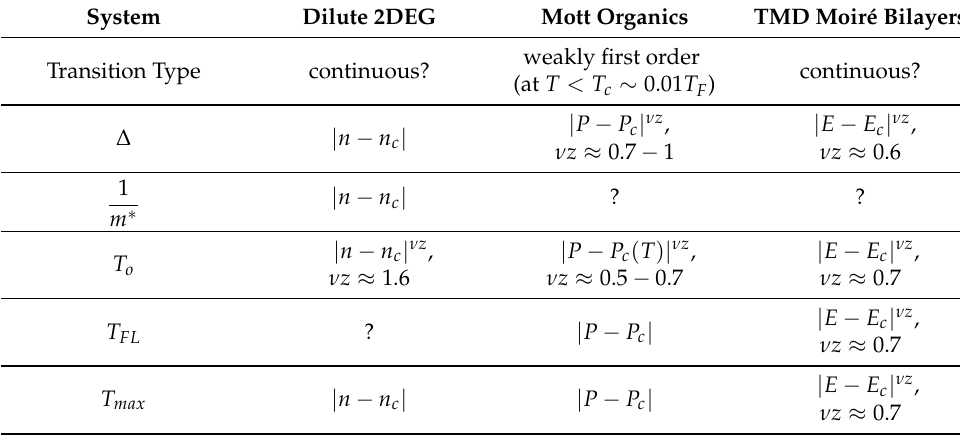
Table 1. A summary of available experimental results for the three classes of systems considered. The sources (references) are given in the text below. Question-marks indicate the lack of reliable data. Fermi liquid ( T 2 ) transport behavior has not been documented in 2DEG systems, in contrast to strong evidence for it in Mott organics and TMD moiré bilayers. Note that the characteristic energy scales ∆ , ( m ∗ ) − 1 , T FL , T max , as well as T o display similar continuous decrease towards the transition in all three systems, consistent with general expectations for quantum criticality. One should keep in mind that the error bars on the estimated exponent could be substantial, since the results typically depend strongly on the utilized fitting range. System Dilute 2DEG Mott Organics TMD Moiré